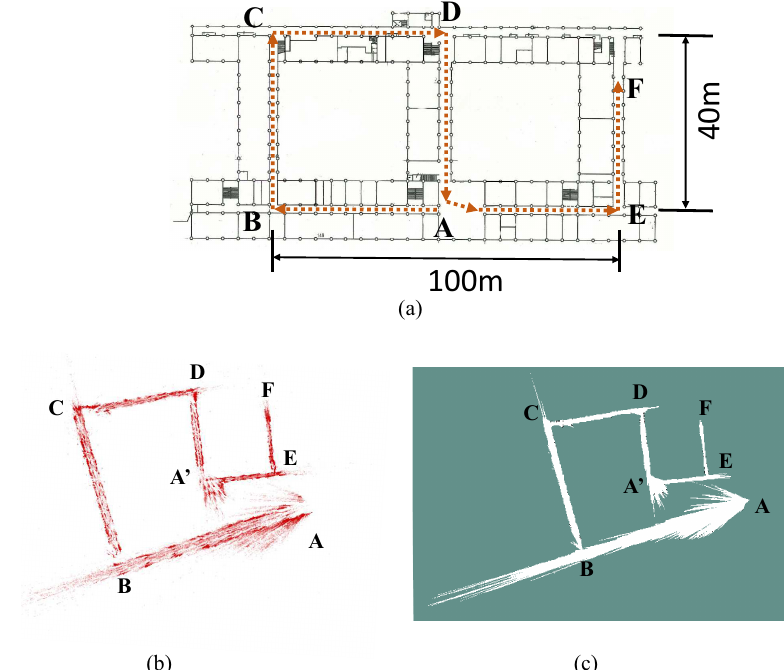
Figure 12. ( a ) The plan of the experimental environment. Red dot arrows represent the direction of camera trajectory, ( b ) scale-drifted point cloud map obtained by monocular SLAM, ( c ) 2D grid map.